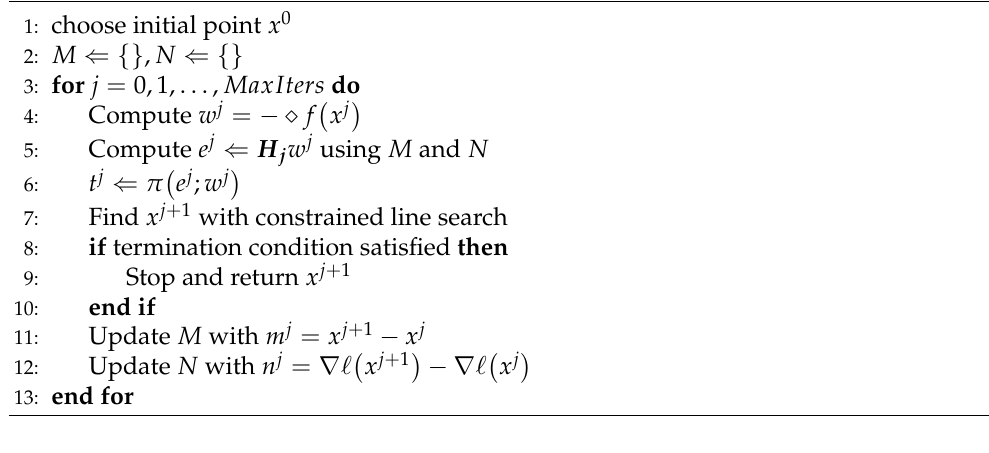
Algorithm 1 Orthant-Wise Limited-memory Quasi-Neton